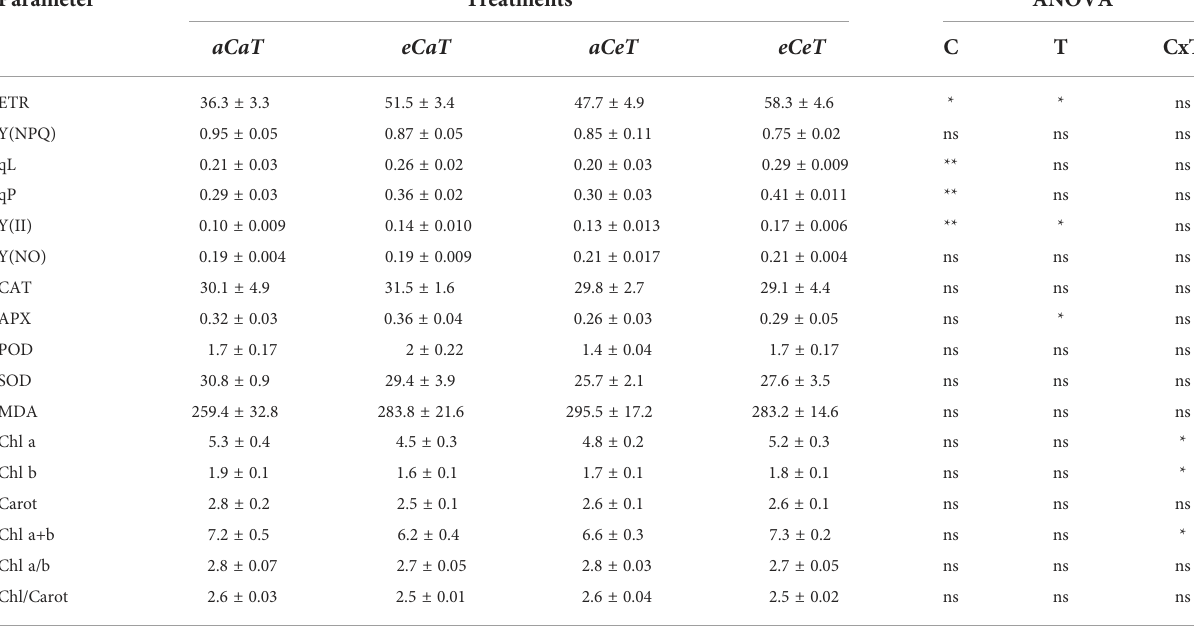
TABLE 1 Chlorophyll fl uorescence parameters, enzymatic activity, malondialdehyde levels, and photosynthetic pigments content measured on the last day of the experimental period in fully expanded leaves of M. maximus developed at two levels of [CO 2 ] and temperature.